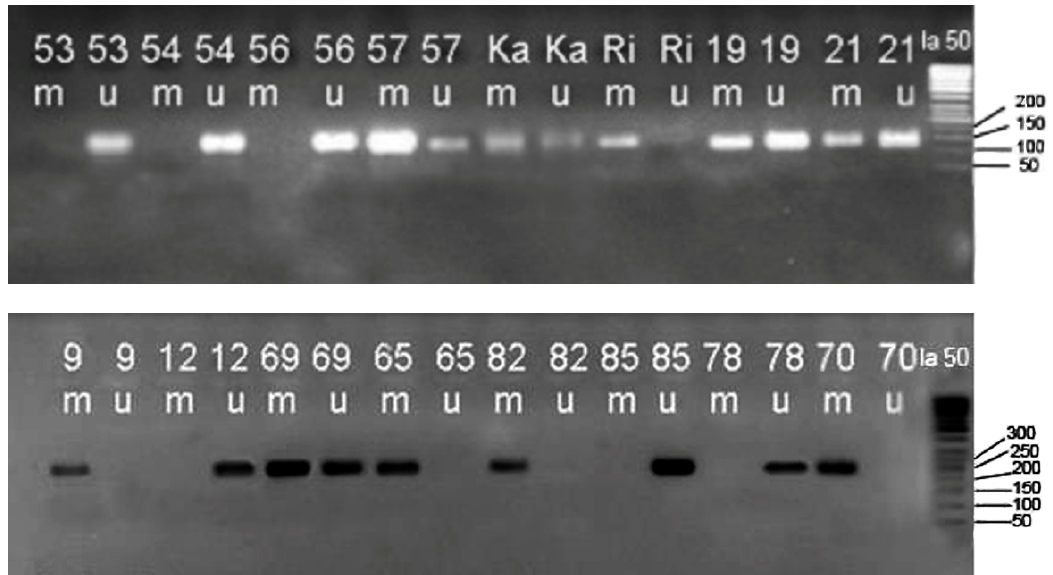
Figure 1. Case specimen methylation-specific polymerase chain reaction (MSP) for miR-137(A) and miR-342(B) visualized using 2% agarose gel and 50 bp ladder. For each sample, two wells were arranged named U and M wells. Presence of a band in M or U well illustrates methylation of the concordant strand. Presence of two bands in both M and U wells show Hemi methylated alleles which are believed to be due to contamination with the normal colonic mucosa.